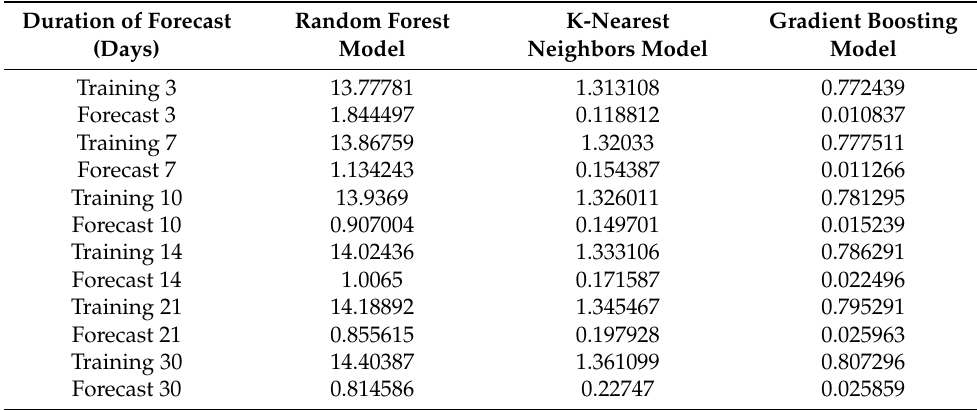
Table 4. Relative error of forecasted new cases for Ukraine (%).